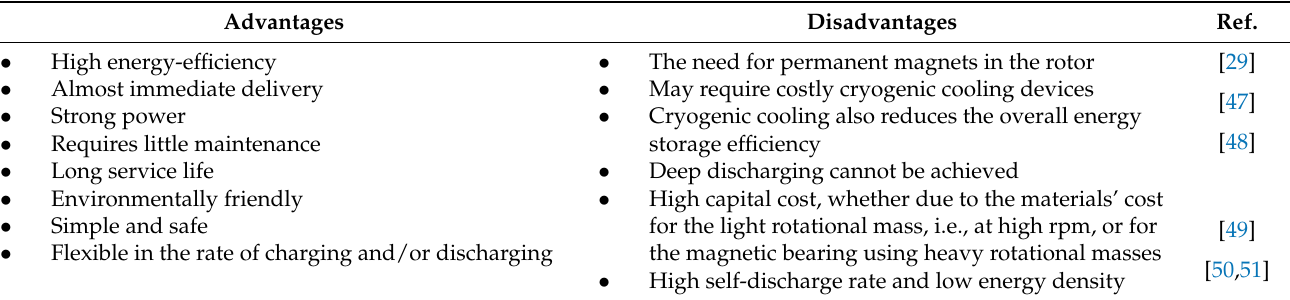
Table 1. Advantages and disadvantages of the